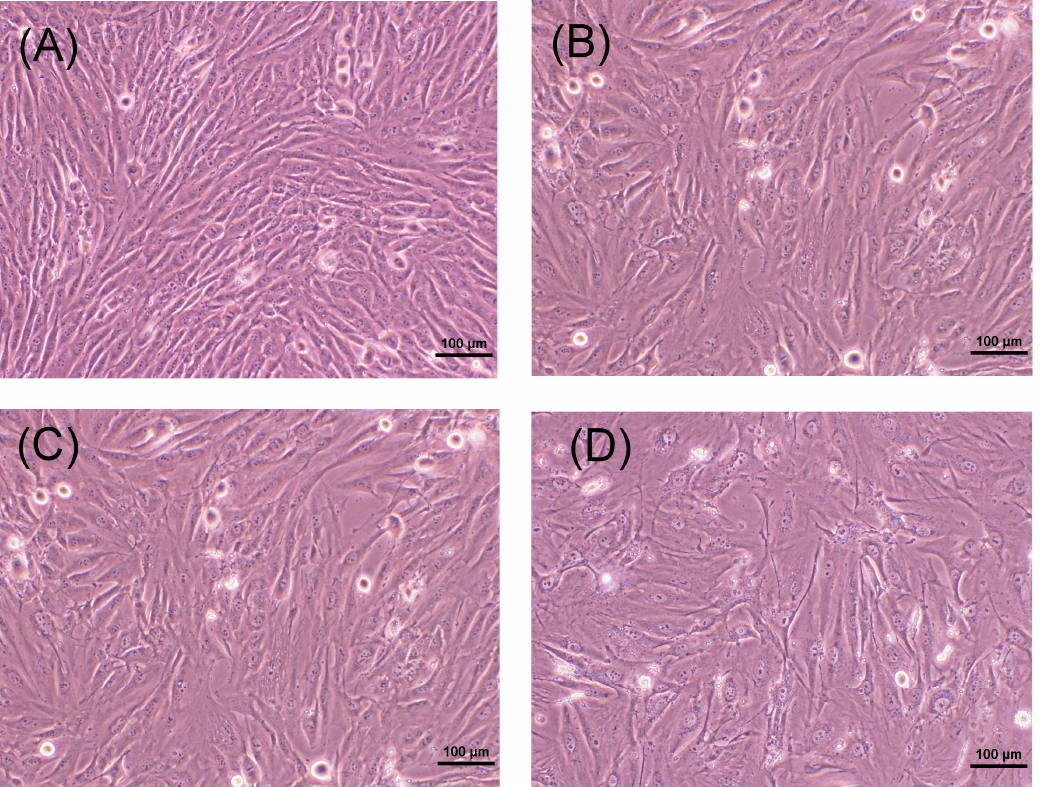
Figure 2. Morphologic changes of MG-63 cells (10 4 cells/well) after exposure to different concentrations of butyrate for three days. ( A ) Control, ( B ) 4 mM butyrate, ( C ) 8 mM butyrate, ( D ) 16 mM butyrate. 100 × original magnification (bar = 100 µ m). One representative result was shown.